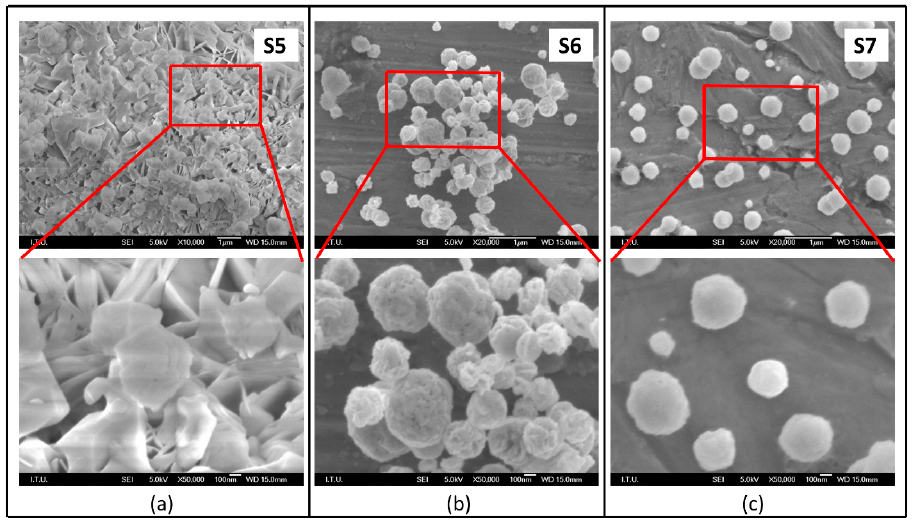
Figure 5. SEM micrographs of nanostructured ZnO particles synthesized at various reaction temperatures at S5 ( a ), S6 ( b ) and S7 ( c ), where concentration (0.02875 mol/L) and flow rate (0.5 L/min) were constant.